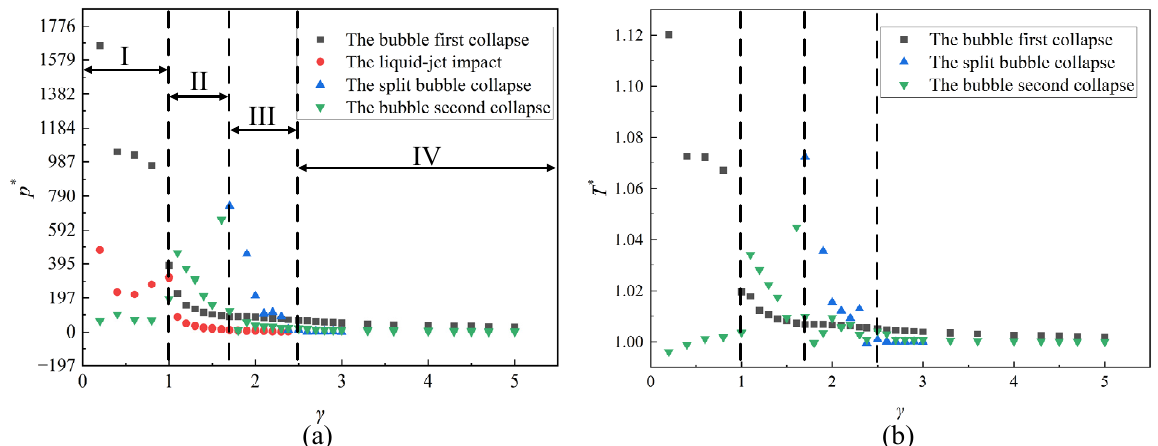
Figure 10. Relationships between various γ values and ( a ) pressure and ( b ) temperature peaks at the wall center.